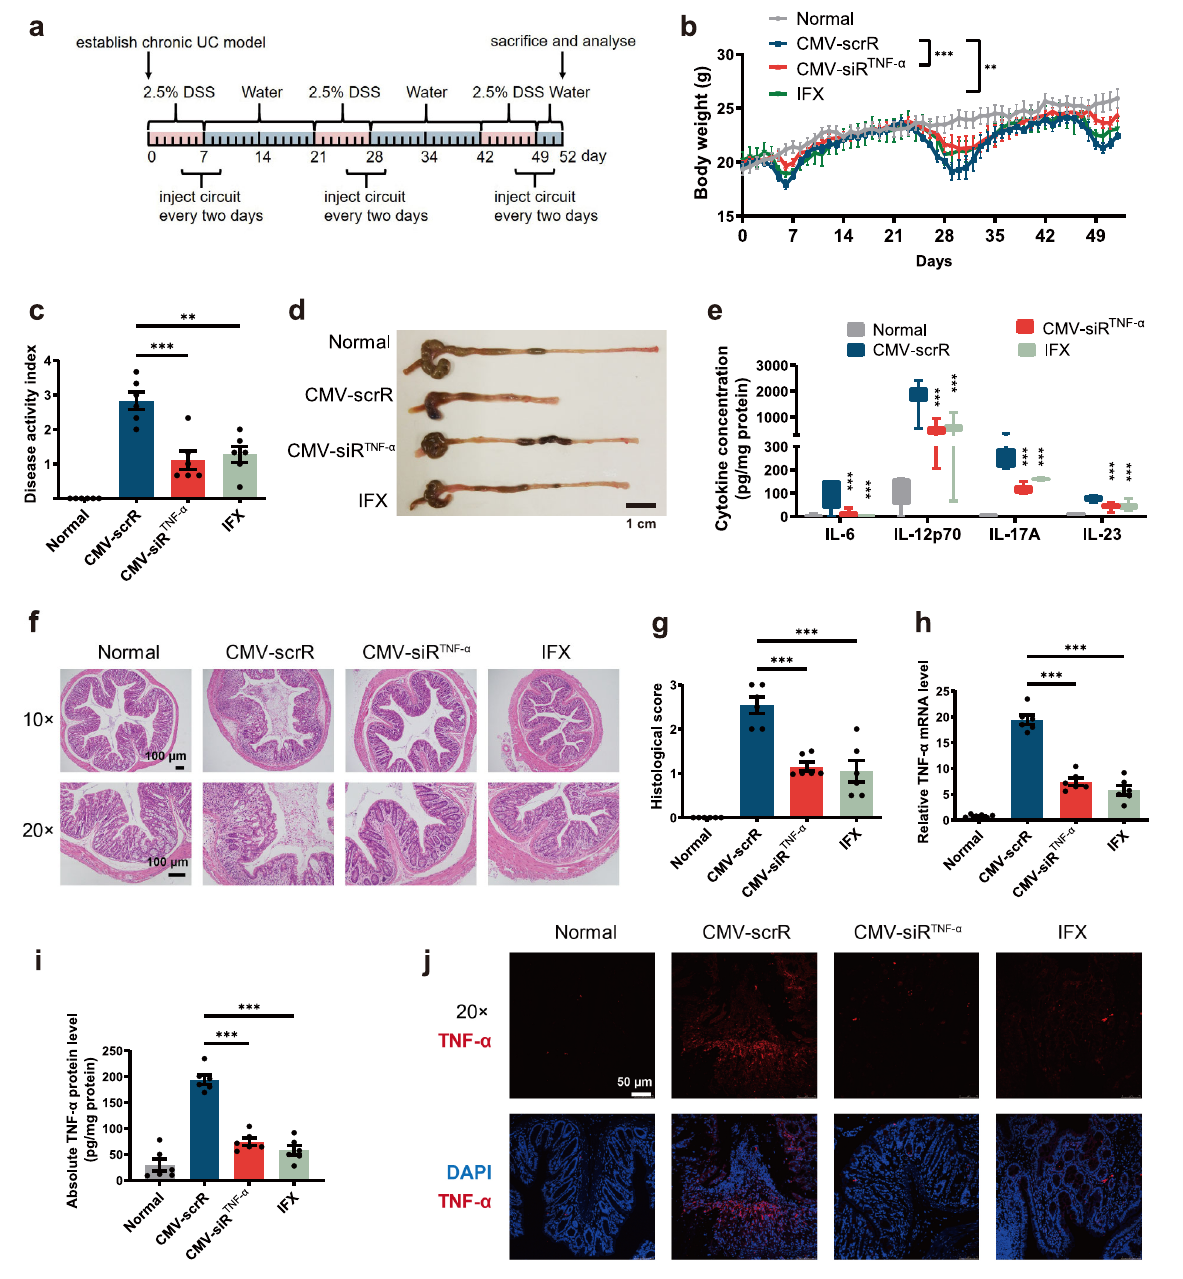
Fig.6|IntravenousinjectionoftheCMV-siR TNF- α circuitprotectsmicefromDSS- induced chronic UC. a Flow chart of the experimental design. b Body weight curves ( n =6 in each group). c DAI scores ( n =6 in each group). d Representative macroscopicfeaturesofcolons.Scale bar:1cm. e Determinationofserumlevelsof IL-6, IL-12p70, IL-17A and IL-23 by ELISA ( n =6 in each group). f Representative imagesofH&Estainingofcolonsections.Scalebar:100 μ m. g